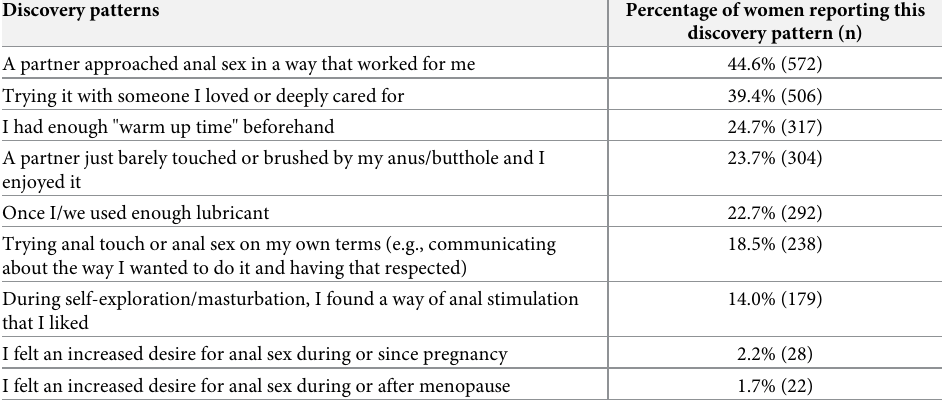
Table 6. Prevalence of patterns in how women first discover that anal touch is pleasurable reported by women endorsing pleasure from any form of anal penetration (N = 1283, weighted). Discovery